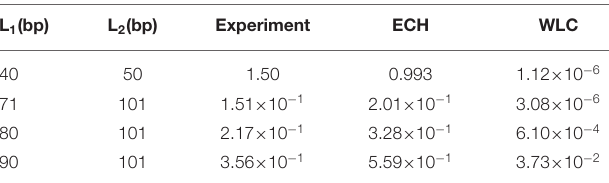
TABLE 1 | j-factor ratios, J ( L 1 ) / J ( L 2 ), predicted using ECH and WLC models compared with experiment [